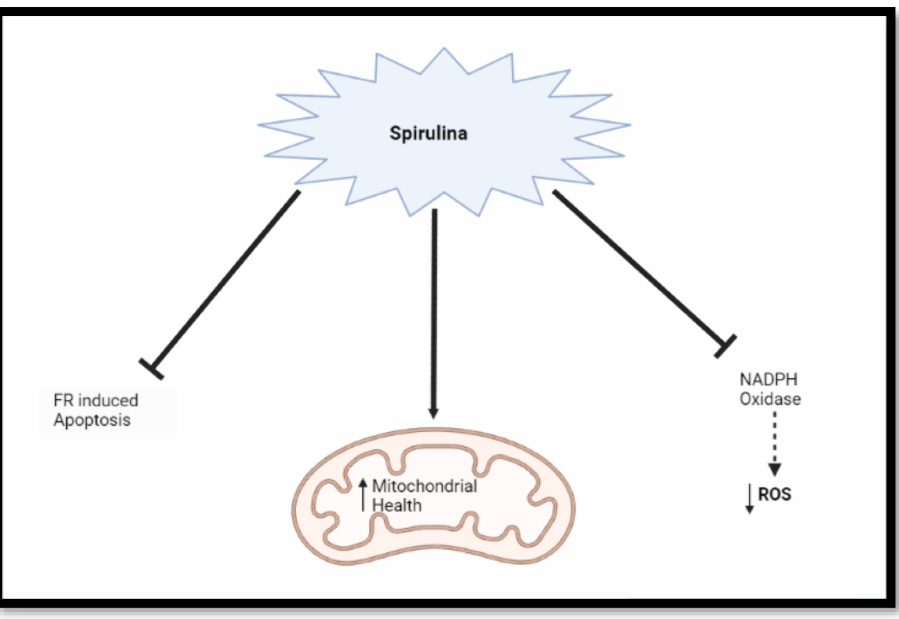
Figure 1. Diagrammatic representation of Spirulina reduction of oxidative stress via several path- ways. Spirulina inhibits NADPH oxidase, reduces ROS, blocks FR-induced apoptosis, and promotes mitochondrial health (Created with BioRender.com, accessed on 17 November 2021).